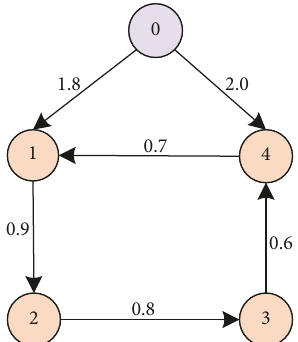
Figure 1: Communication topology among agents in the